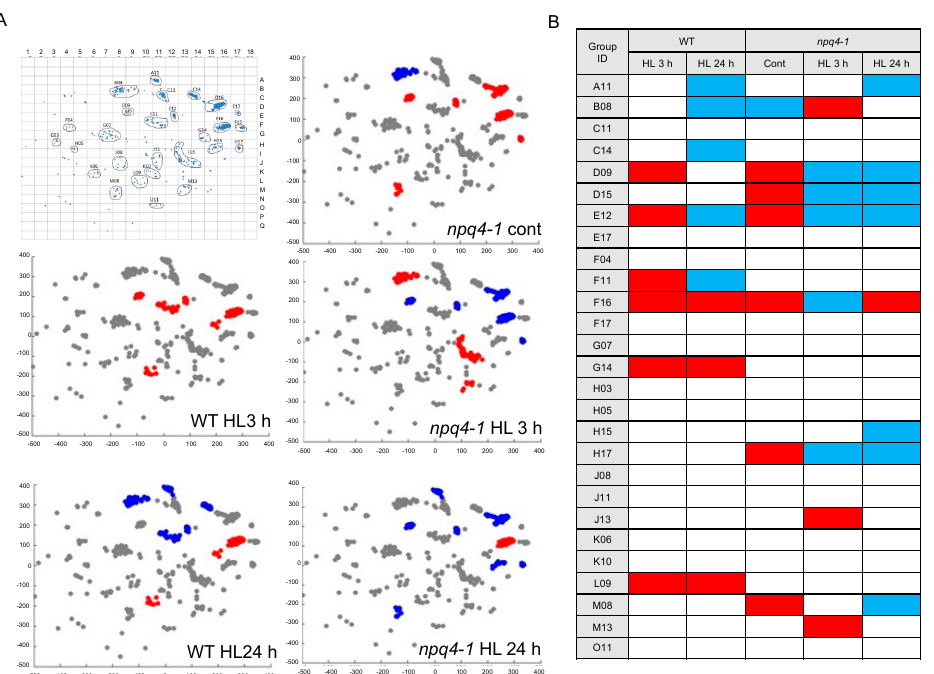
Figure 8. The co-expressed gene sets enriched in wild-type and npq4-1 mutants during high light illumination. ( A ) The position on the co-expression terrain map of differentially co-expressed gene sets is represented. Gene sets positively enriched for each treatment are represented in red color and conversely, gene sets negatively enriched are represented in blue color. The x, y coordinates of the gene sets on the co-expression terrain map correspond to the names of the gene sets; ( B ) Gene sets were visualized by heat map. WT, wild-type; MT, mutant; HL, high light. The genes encoding Solanesyl Diphosphate Synthase 2 ( SPS2 ) and a tocopherol cyclase ( Vitamin Deficient 1 ; VTE1 ), involved in PQ and tocopherol biosynthesis, were notable in